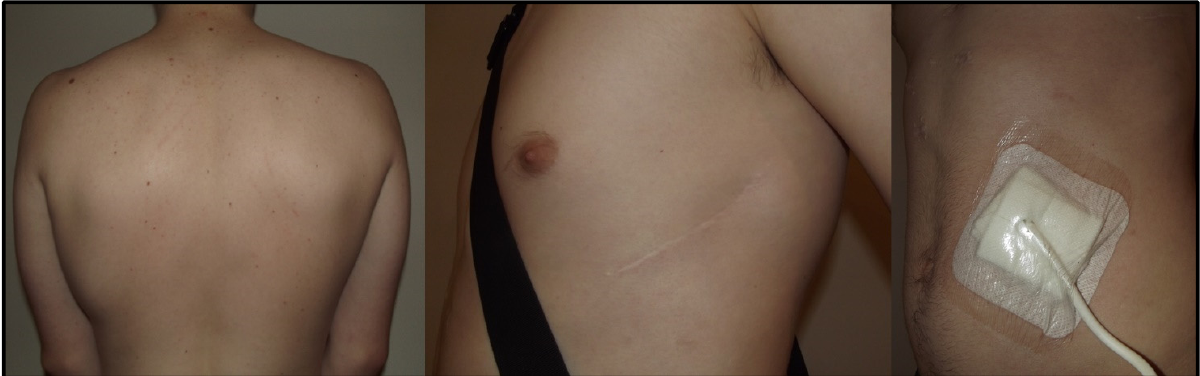
Figure 1. Patient 2. Cosmetic effect after S-ICD implantation in a 17-year-old patient with dilated cardiomyopathy and LVAD HeartMate 3. S-ICD, subcutaneous implantable cardioverter defibrillator; LVAD left ventricular assist device.